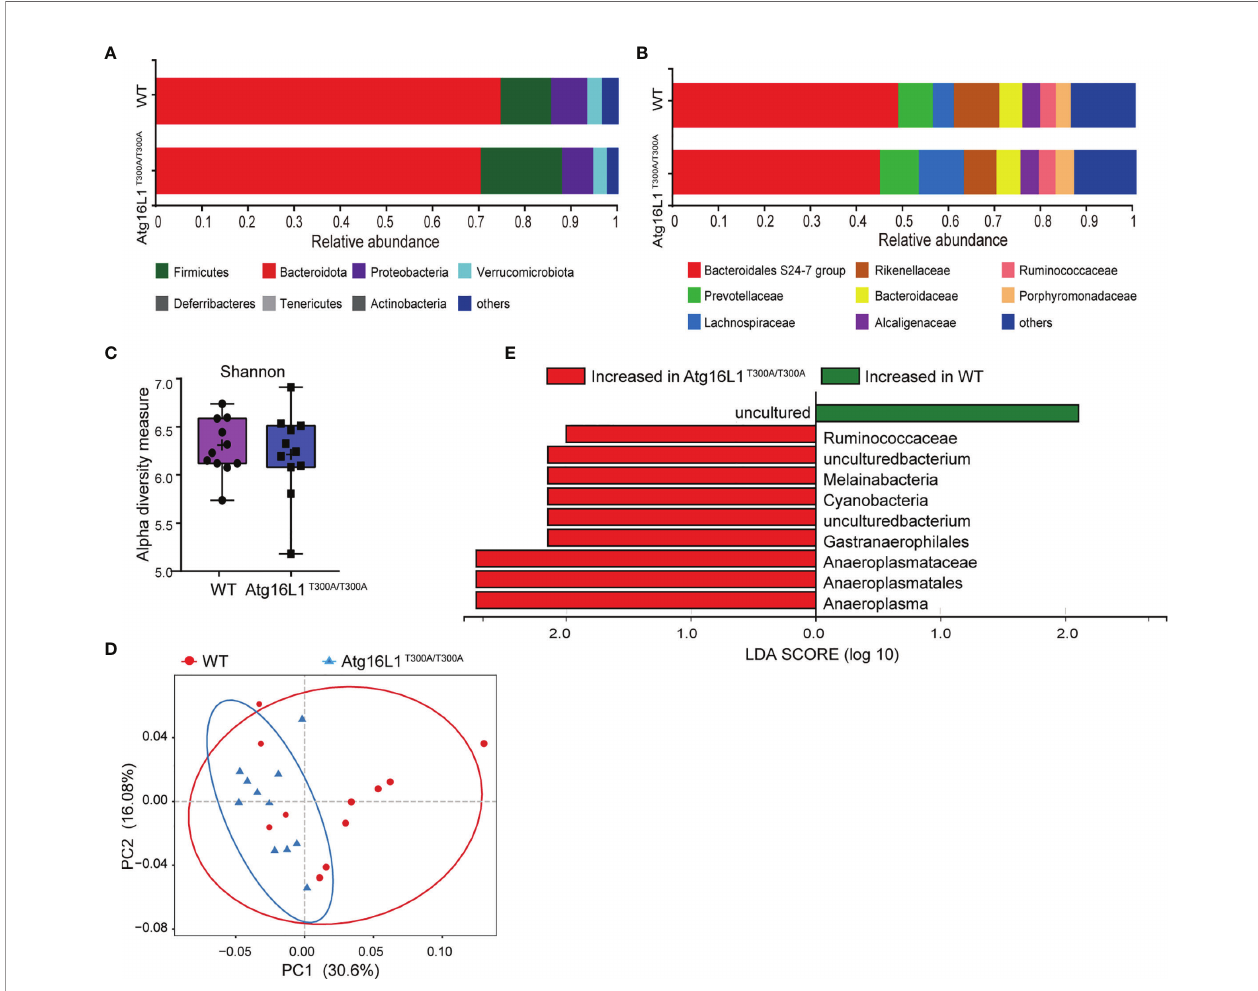
FIGURE 1 | Atg16L1T300A mice display a slightly different microbial composition in fecal at a steady state. WT and Atg16L1 T300A/T300A mice were cohoused in a speci fi c-pathogen-free (SPF) facility for 4 – 5 weeks after weaning at the third week of birth. (WT mice n = 11 and Atg16L1 T300A/T300A mice n = 11). Stool samples were collected and analyzed by 16S rRNA gene amplicon sequencing. (A, B) The relative abundance of dominant bacteria at phyla (A) and families (B) level microbiota composition determined by 16S rRNA gene amplicon sequencing of stool samples from SPF cohoused WT vs. Atg16L1 T300A/T300A mice at steady state. Colored bars represent the relative abundance of particular taxa averaged in each group. (C) Box-and-whisker plot (boxes show median, whisker denotes minimum to maximum range) of microbiota alpha-diversity within the fecal microbiomes of WT vs. Atg16L1 T300A/T300A SPF mouse samples calculated using the Shannon index. (D) PCoA plot of the fecal microbiota composition (unweighted UniFrac distances). (E) Histogram of LDA value distribution identi fi ed by LEfSe analysis. Each symbol represents an individual animal (non-parametric test followed by a Mann – Whitney